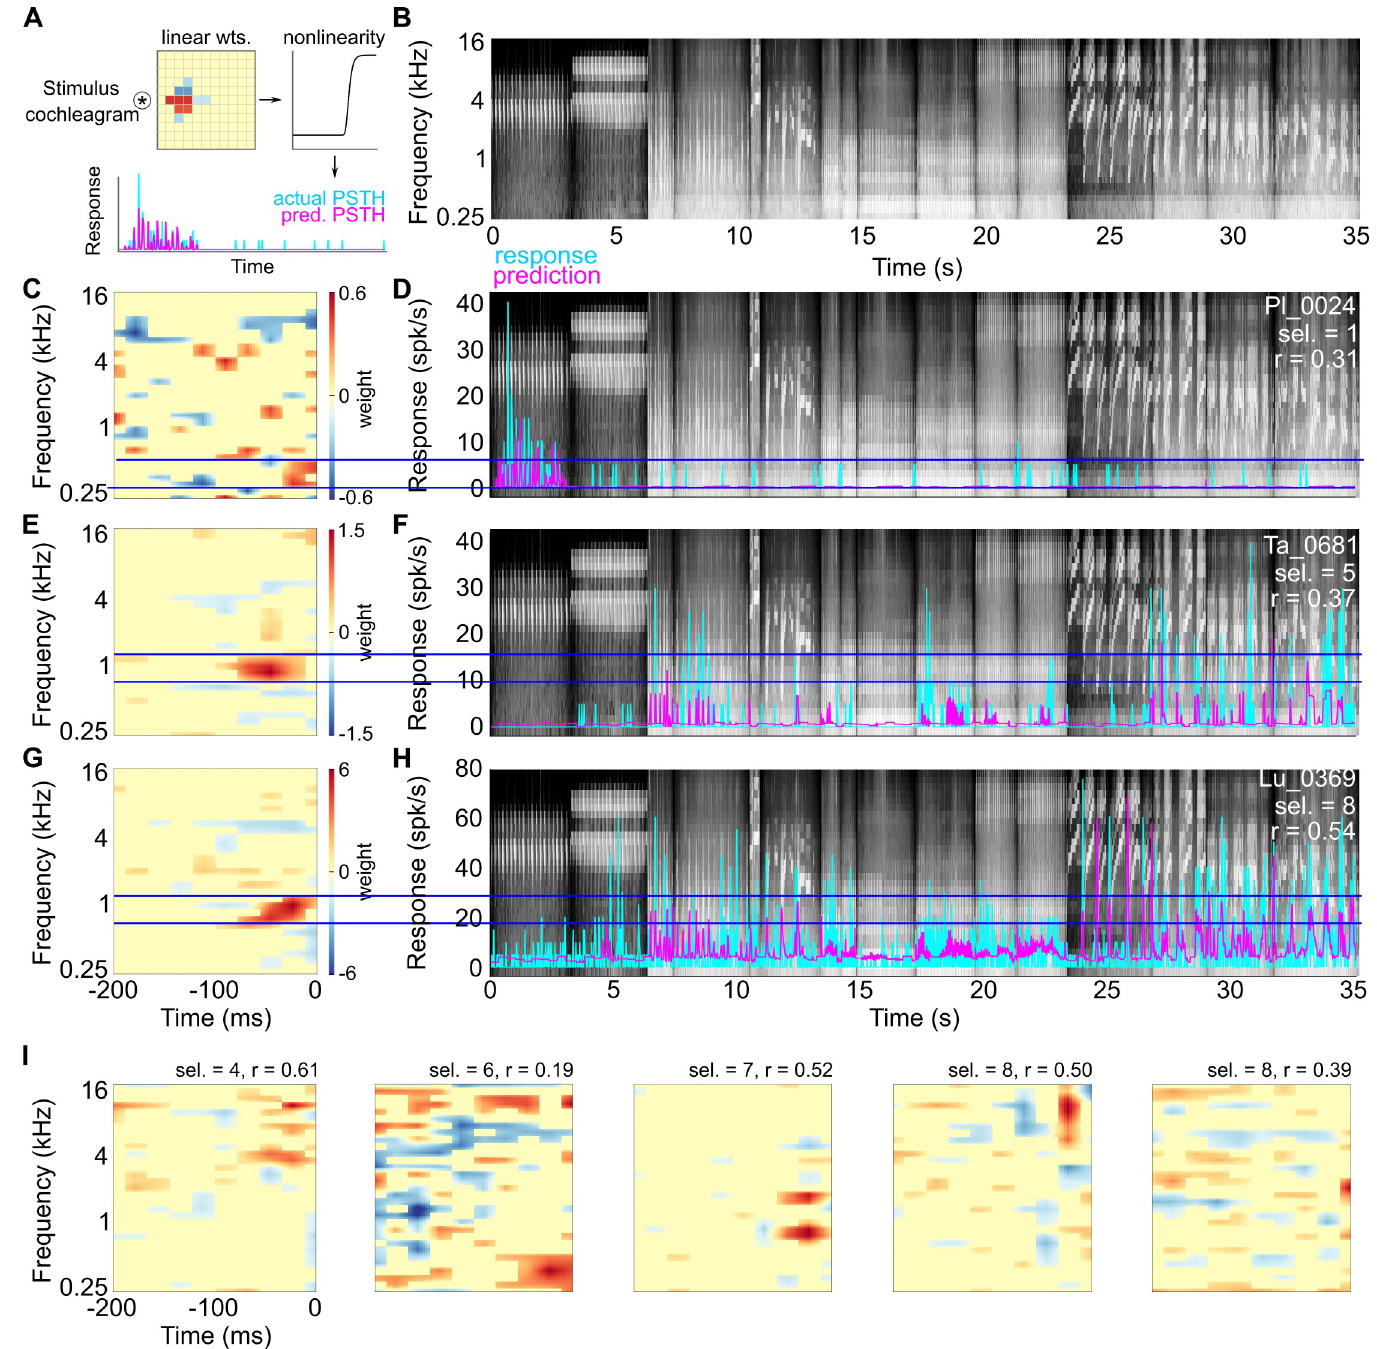
Fig 5. STRF estimates of example A1 L4 neurons. (A) Schematic of the LN model architecture used to estimate STRFs. (B) Stimulus cochleagram of 16 call stimuli (8 categories) used as the input to the model. (C, E, G) Mean STRF estimates of 3 A1 L4 neurons with a range of selectivity values. (D, F, H) Comparison of predicted PSTHs (magenta) and observed responses (cyan) of these 3 neurons. Horizontal blue lines denote the extent of the frequency tuning of the STRFs. (I) Additional examples of A1 L4 STRF estimates (sel. = call selectivity, r = correlation between predicted and actual responses derived from the validation data set). Data underlying this figure can be found in Supporting information file S5 Data. LN, linear–nonlinear; PSTH, peristimulus time histogram; STRF, spectrotemporal receptive field.